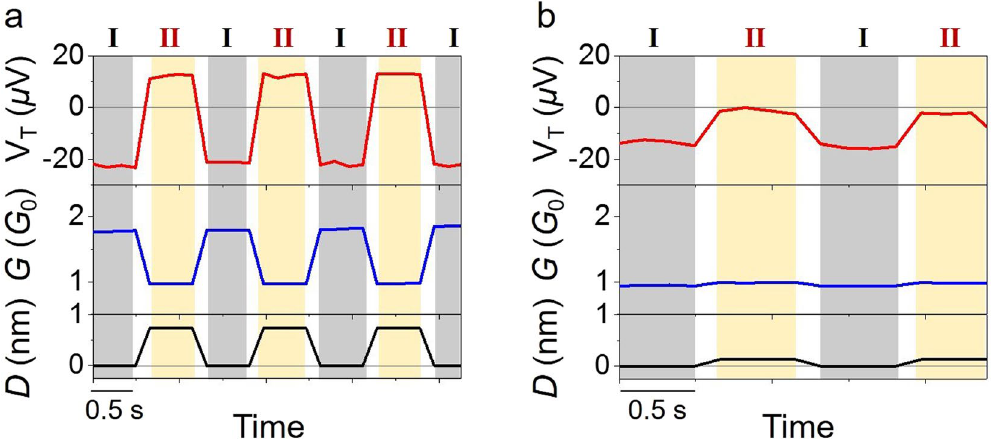
Figure 2. Au atomic contact as a thermoelectric voltage switch. Periodic modulation of the thermoelectric voltage ( V T ) and conductance ( G ). The modulations were induced by stretching/compressing the junction. The elongation/compression distance ( D ) was ( a ) 0.73 nm and ( b ) 0.10 nm. Here, the point of zero elongation ( D = 0) is taken as the most compressed state. The temperature difference was ( a ) 10 K and ( b ) 4.4 K, and the average temperature was 25